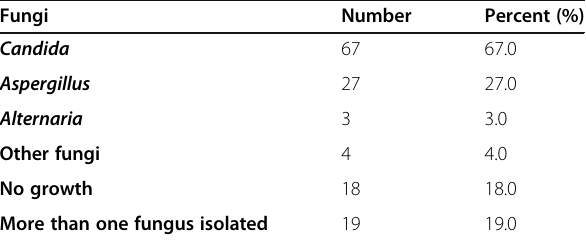
Table 6 Isolated fungi on cultures among the studied cases Fungi Number Percent (%)